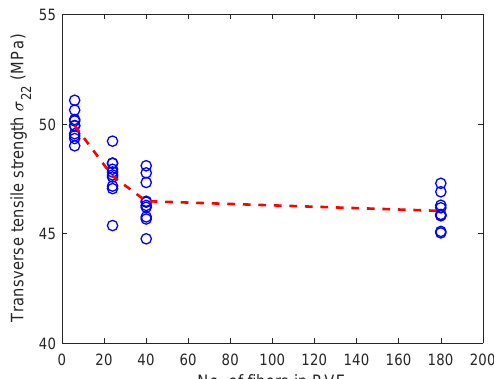
f = 0.5. (D’Mello and